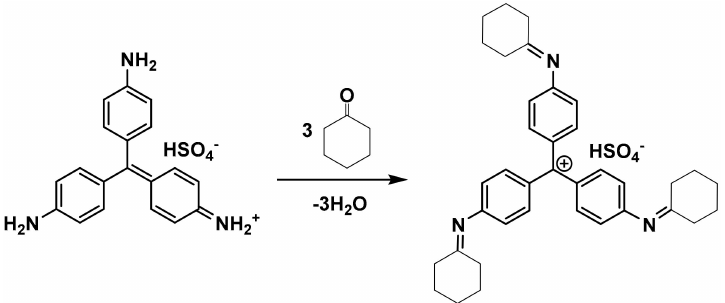
Figure 3. Colorimetric detection mechanism of cyclohexanone using an amine-based indicator, pararosaniline, in the formation of an imine product.